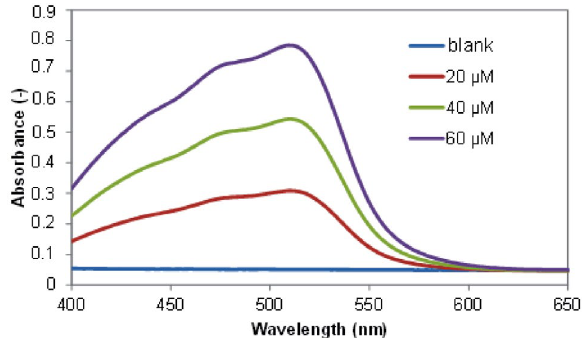
Figure 2. Absorption spectra of [Fe(PHN) 3 ] 2+ complex for different Fe(II)